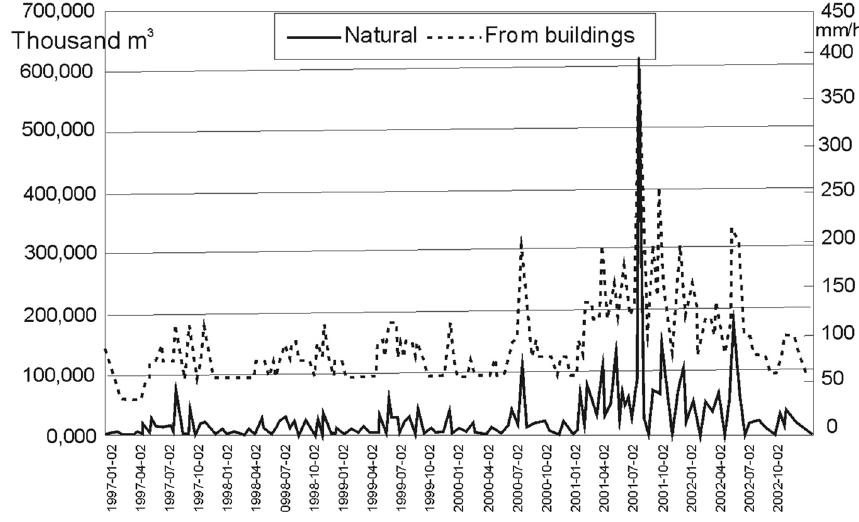
Fig. 12 Surface retention in natural conditions and with building development in catch- ment of the Potok